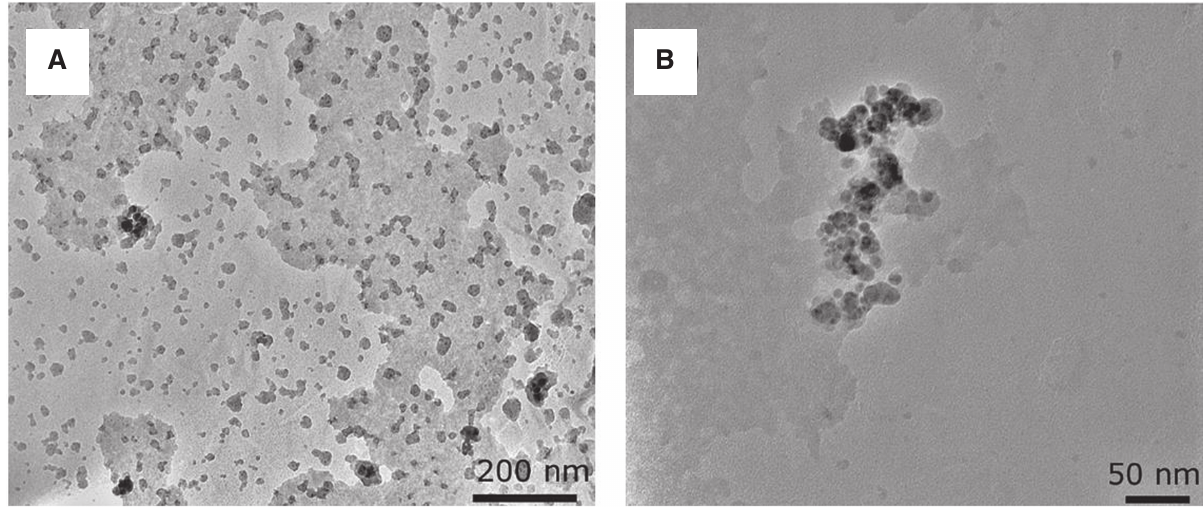
Figure 3: TEM images of silver nanoparticles synthetized in an aqueous solution of silver nitrate (0.01 m), ethanol, and ammonia via sonica- tion for 11 min.